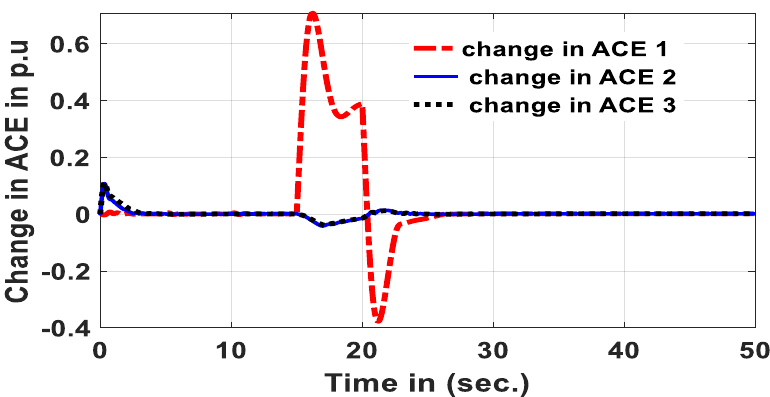
Figure 23. Change in ACE responses of area 1, area 2, and area 3 for random load change in area 1 only.